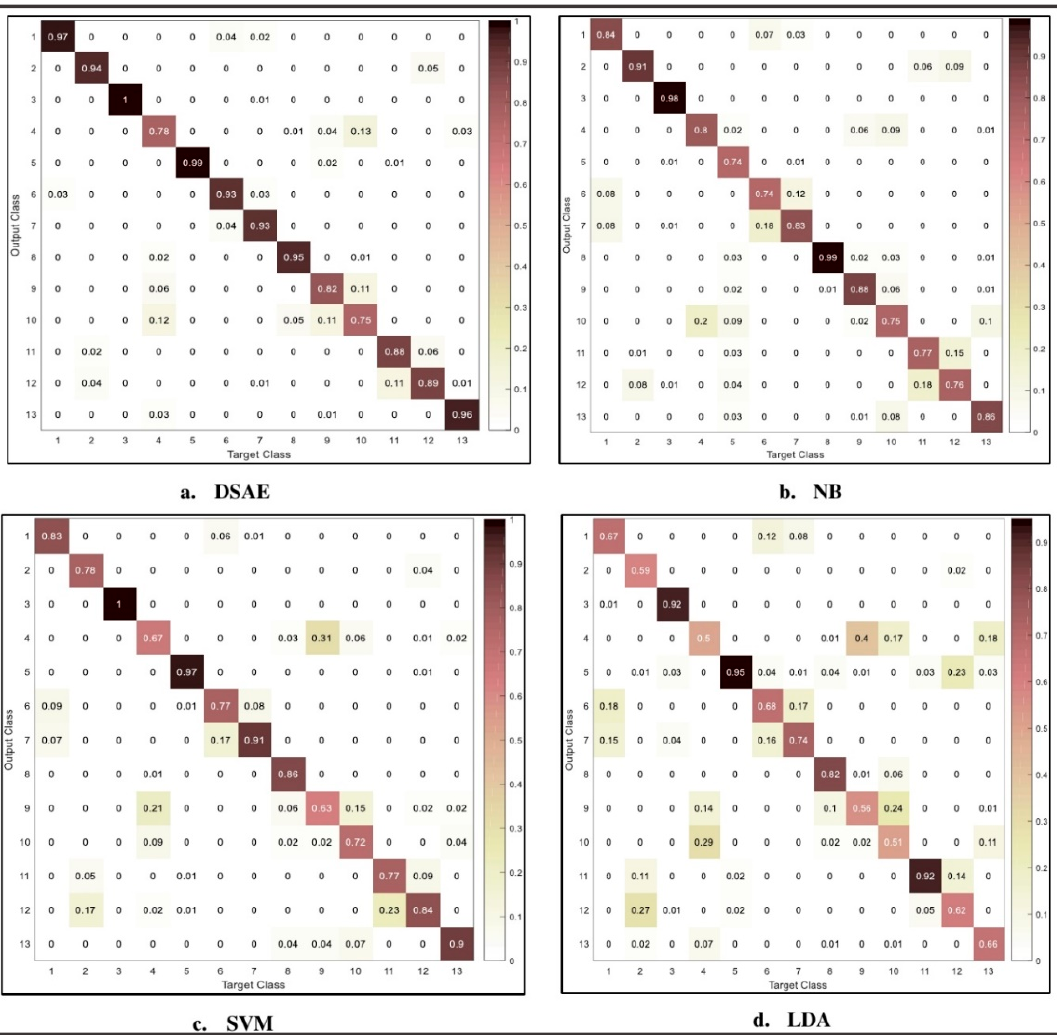
Figure 8. Confusion matrix showing the performance results of each method using the 3-D acceleration sensor (Note: DSAE (Deep stacked autoencoder), NB (Naïve Bayes), SVM (Support vector machine), LDA (Linear discriminant analysis). Activities: 1—walk, 2—stand, 3—jog, 4—sit, 5—bike, 6—upstairs, 7—downstairs, 8—type, 9—write, 10—coffee, 11—talk, 12—smoke, 13—eat. Table 6. Performance results for fusion of different data samples.